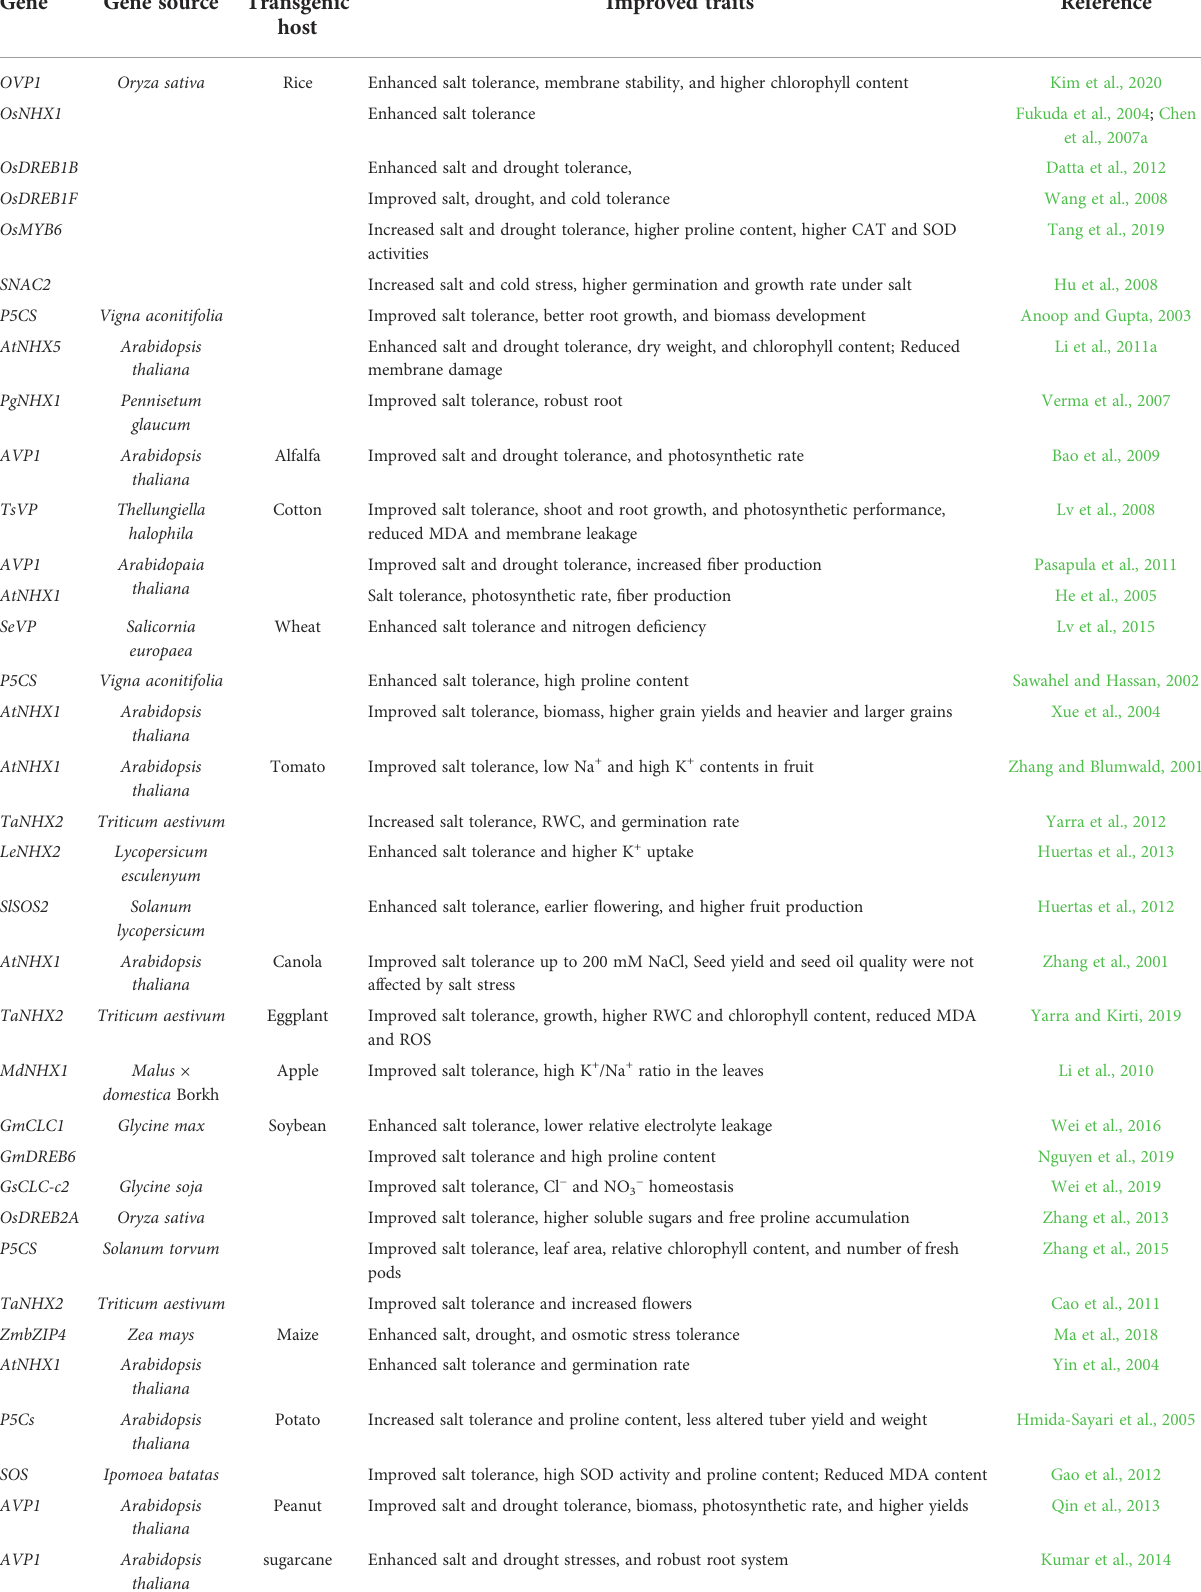
TABLE 1 Improving plant salt stress tolerance through genetic